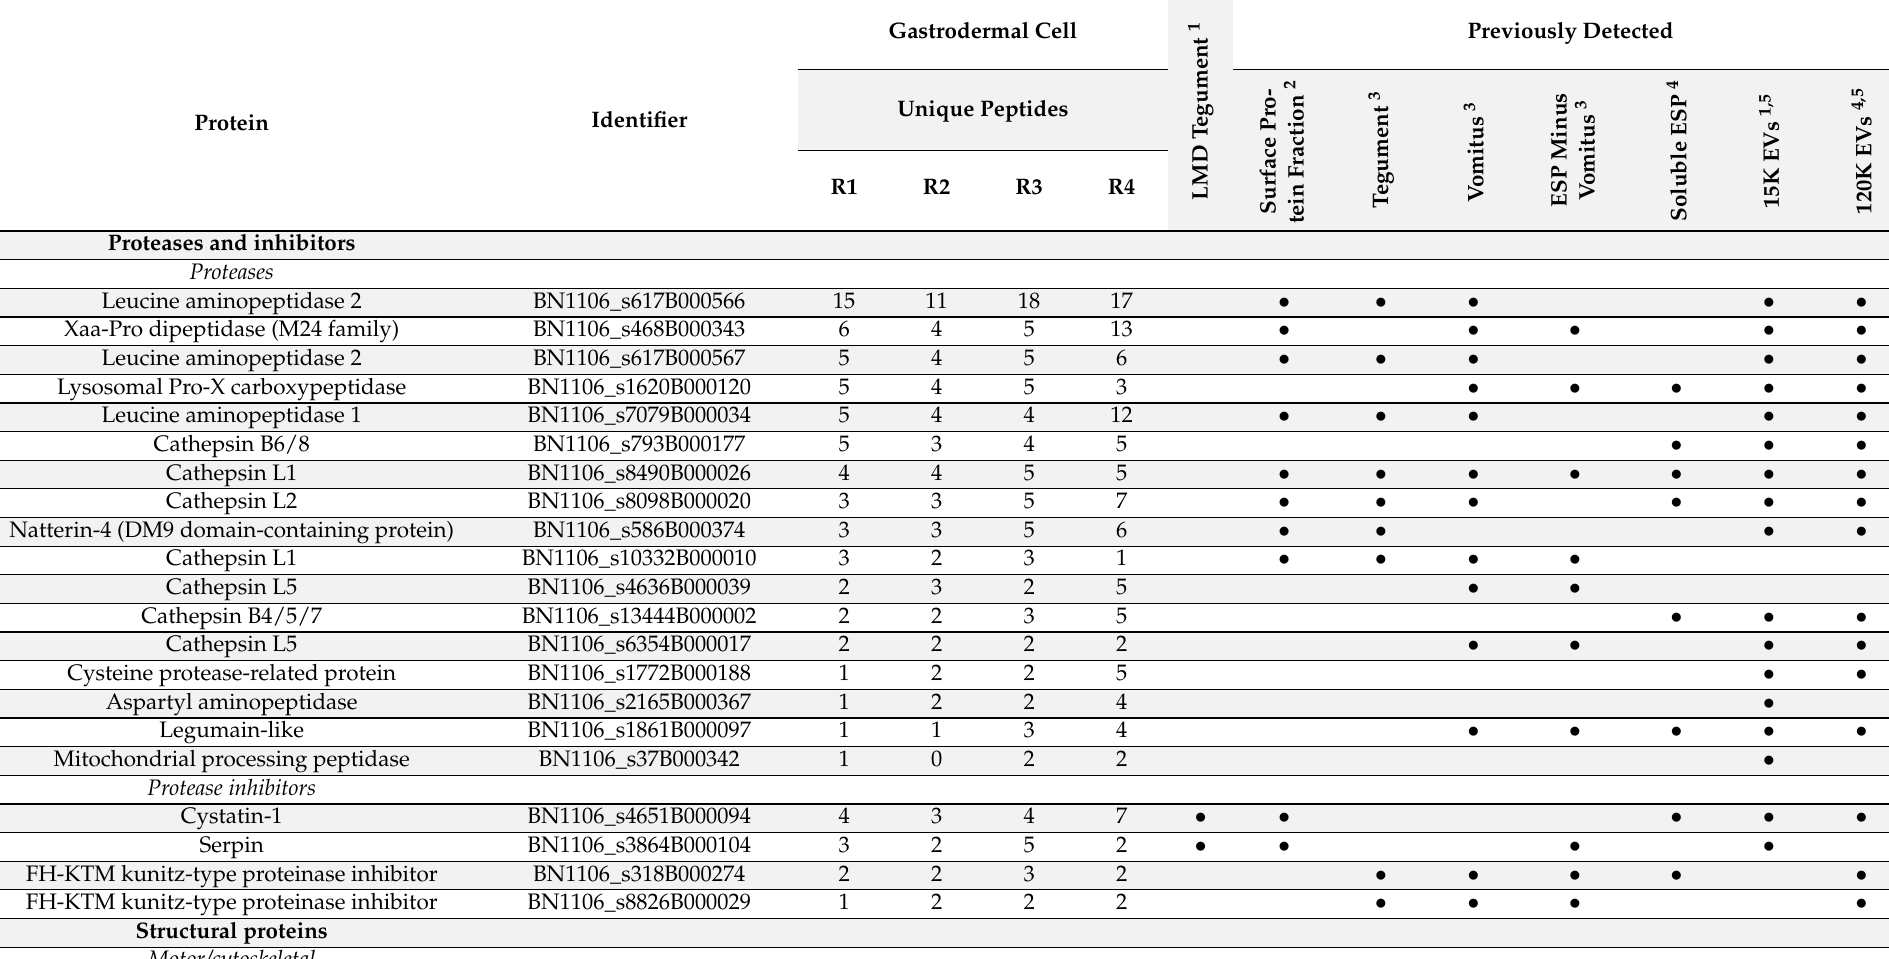
Table 1. Proteases, protease inhibitors, pumps, transporters, and structural, signal transduction, and secretory pathway proteins identified in the gastrodermal cells of adult F. hepatica and compared with proteins identified in the laser microdissected (LMD) tegument (this study), as well as previously reported surface, tegument, and excretory/secretory proteins (ESP). A dot indicates a shared protein. R1–4 = replicates 1–4. 1 This study, 2 [21], 3 [22], 4 [17], 5